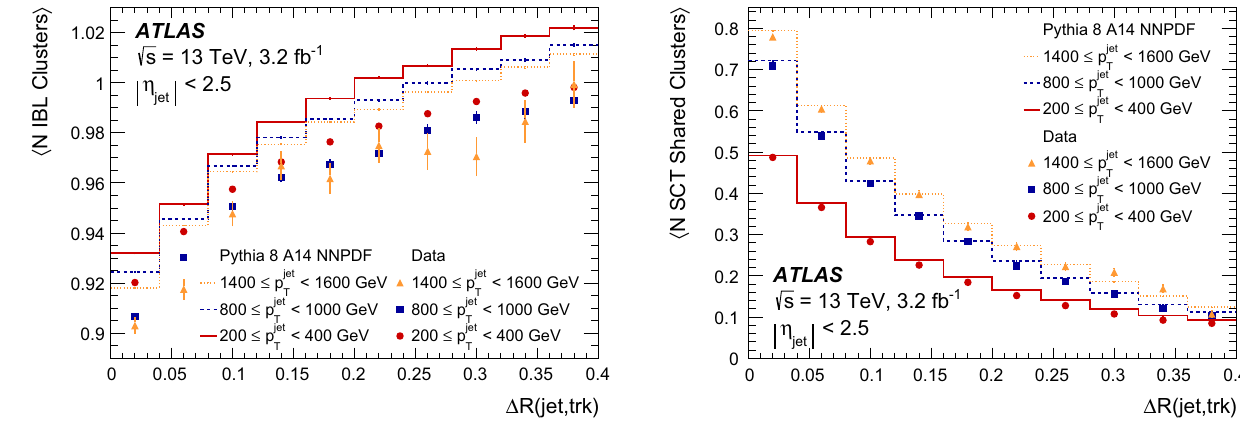
Fig. 7 The average number of shared SCT clusters for primary tracks with a production vertex before the IBL is shown as a function of the angular distance of the track from the jet axis. Data (markers) and dijet MC (lines) samples are compared in bins of jet p T . Due to the lack of charge information and the coarse sensor dimensions, the clusters cannot be readily identified as merged